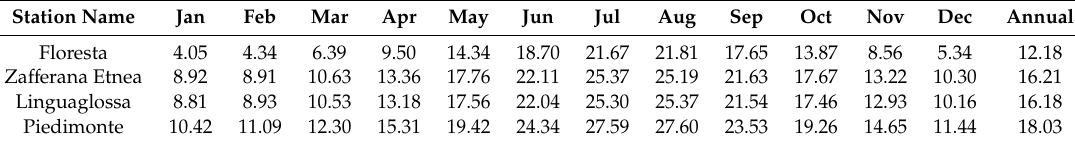
Table 5. Monthly and annual means of temperature data (in ◦ C) observed in the period 1981–2000.